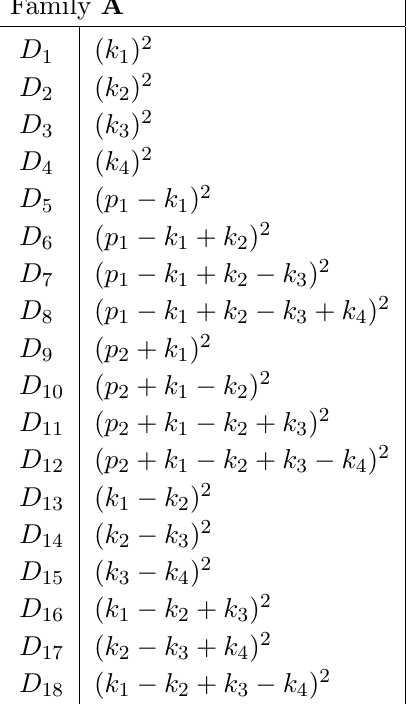
Table 1 . A single Reduze 2 integral family covers all planar four-loop form factor topologies. The permutation symmetry group of A above has order forty-eight. Using this family, integrals over ((cid:5) 4 d d k i )((cid:5) 18 D (cid:0) (cid:23) j i =1 j =1 j